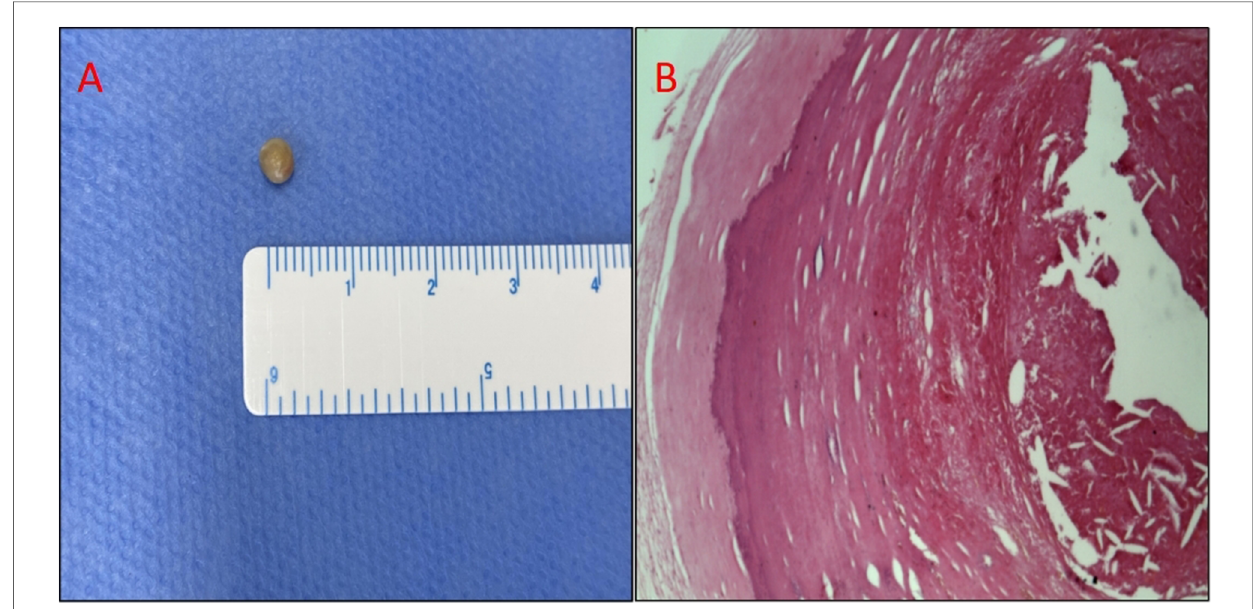
FIGURE 7 ( A ) Photograph of the retrieved embolus: gray globular tissue with a diameter of 4 mm. ( B ) Photomicrograph of the embolus. Hematoxylin and eosin staining. At the center of the embolus is fi brinoid necrosis with a few mixed red blood cells, and the surrounding is a thick layer of fi brotic tissue with hyaline degeneration and peripheral calci fi